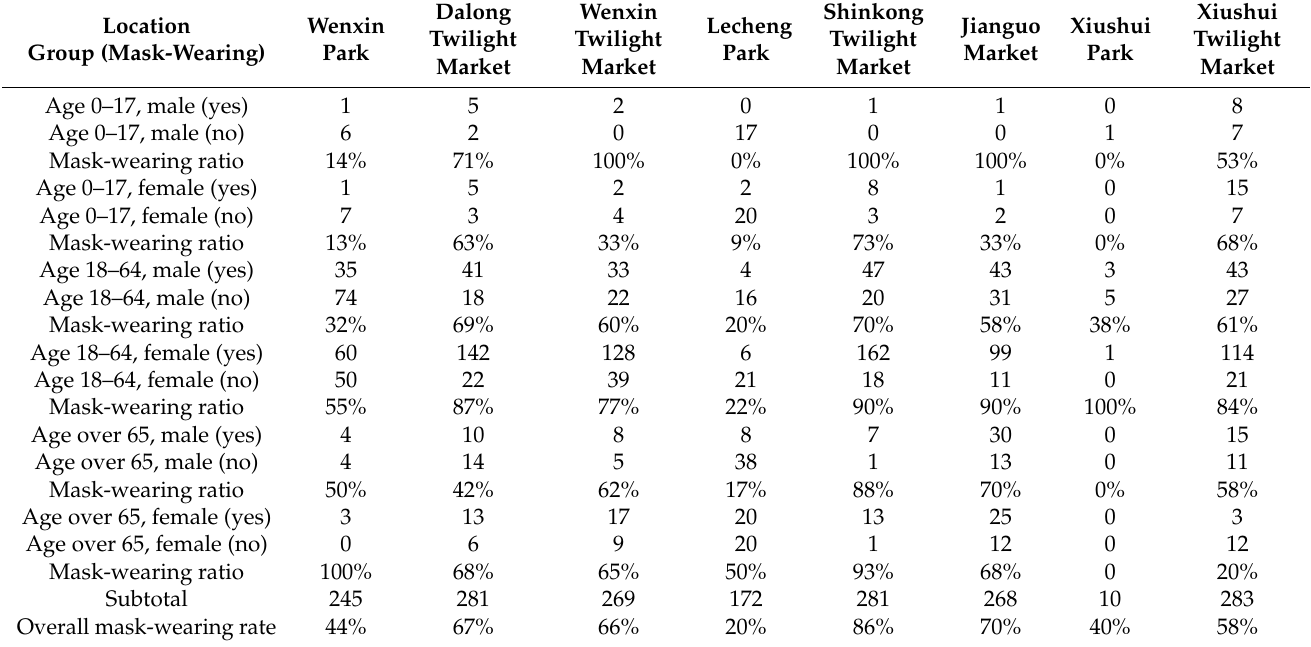
Table 3. Rates of mask-wearing, second observation, by estimated demographic